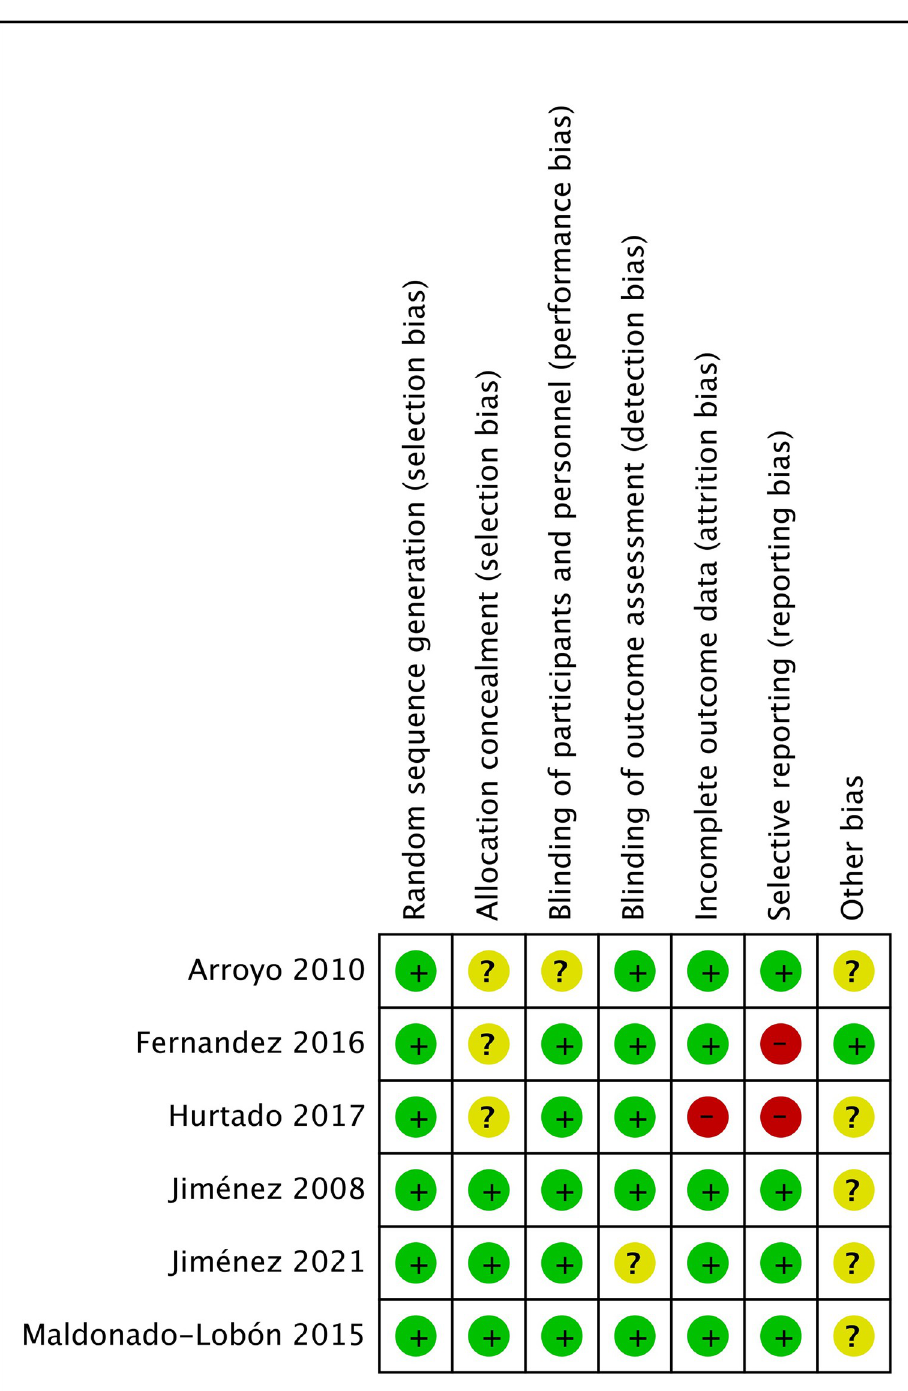
PLOS ONE | https://doi.org/10.1371/journal.pone.0274467 September 9, 2022 6 /